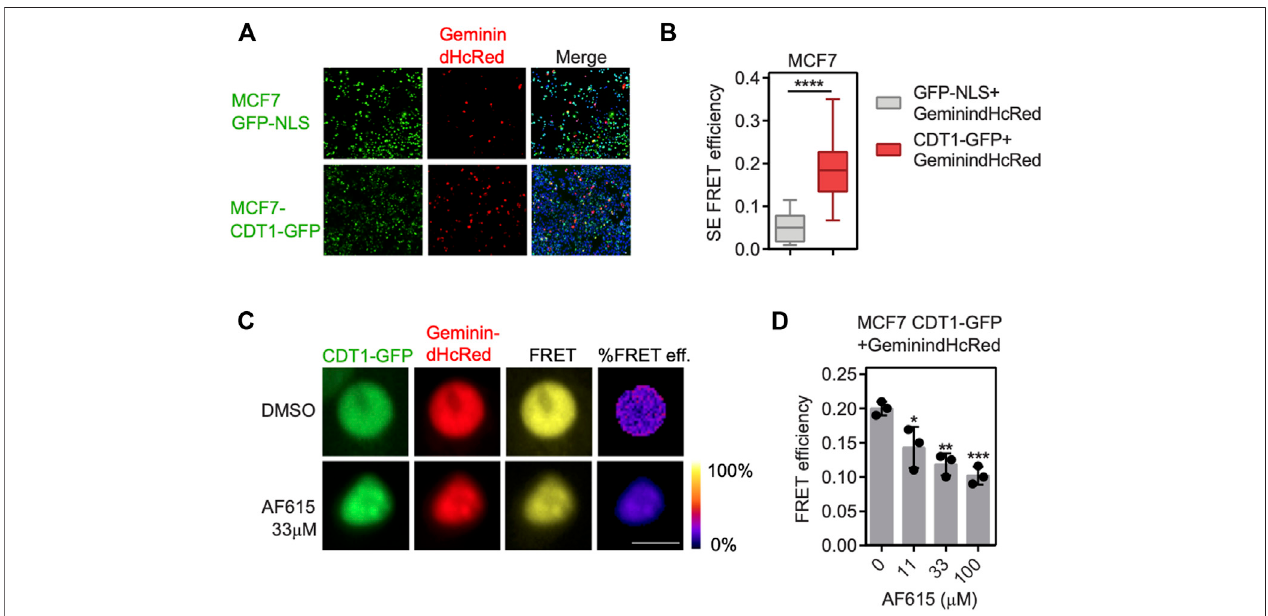
FIGURE 2 | Compound AF615 inhibits CDT1-Geminin protein-protein interaction in cancer cells. (A) Representative images of MCF7CDT1-GFP and MCF7GFP- NLS transiently transfected with Geminin-dHcRed for 24 h. (B) Graphical representation of the quanti fi cation of SE-FRET ef fi ciency. (C) Representative images of SE- FRET of MCF7CDT1-GFP transfected with Geminin-dHcRed treated for 24 h with 33 μ M compound AF615. GFP-NLS + Geminin-dHcRed vs. CDT1-GFP + Geminin- dHcRed, **** p < 0.0001. (D) Quanti fi cation of the SE-FRET ef fi ciency. Dots represent the mean FRET values of three independent biological repetitions. 0 μ